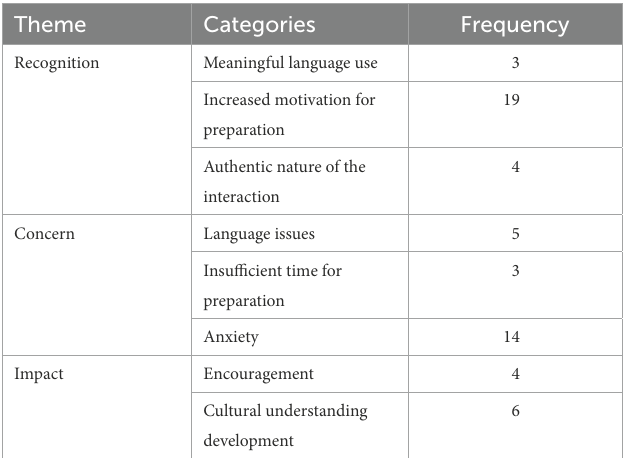
TABLE 2 A coding scheme of student experience on videoconferencing